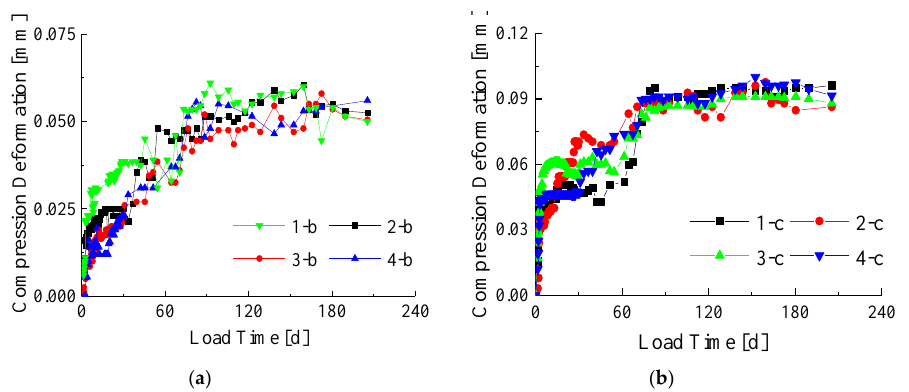
Figure 6. Creep-time curves under the same load conditions (without initial displacement): ( a ) The load level of 40%Ny; ( b ) The load level of 70%Ny.